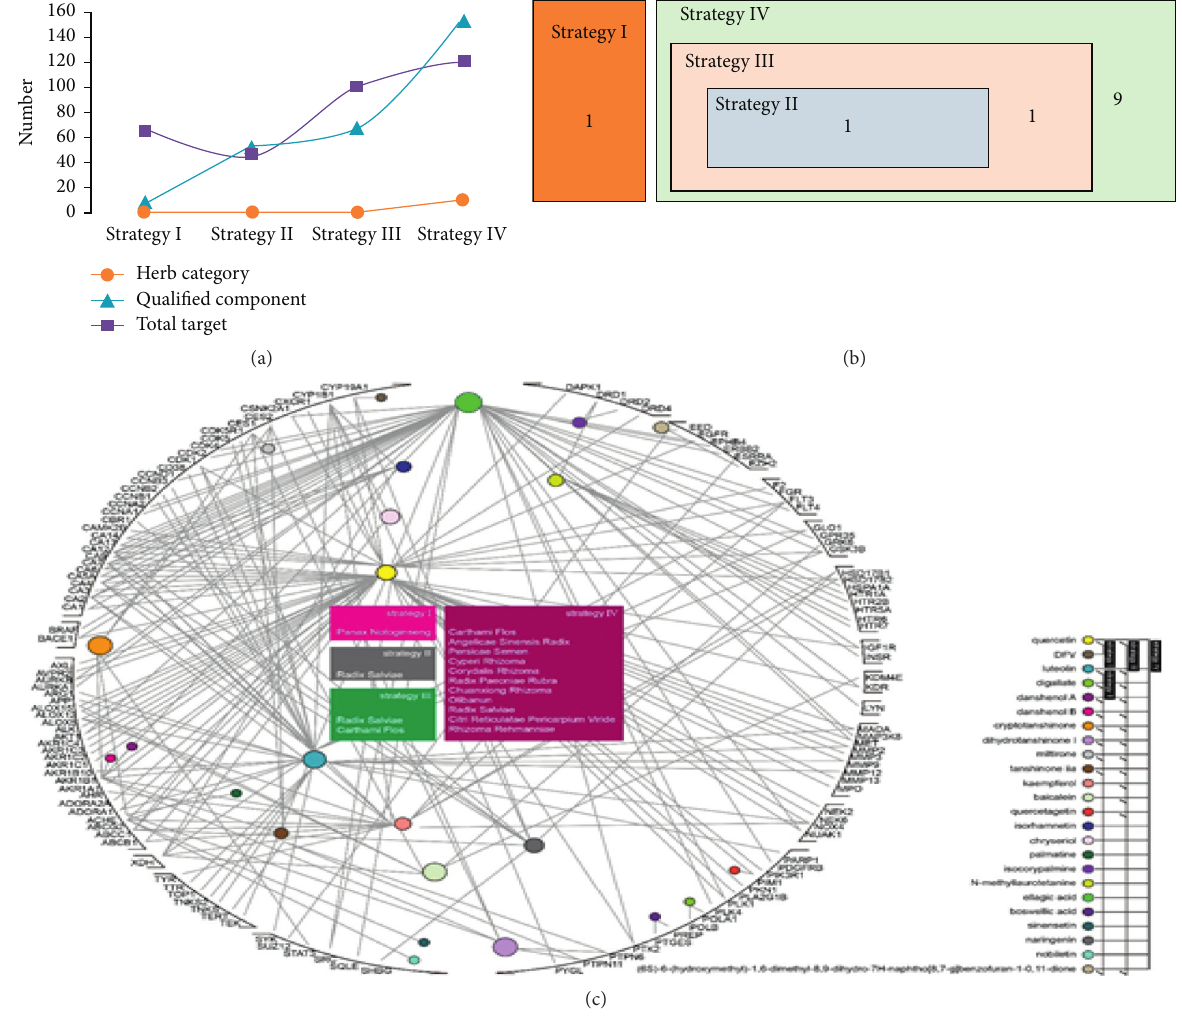
Figure 1: Four herbal strategies. (a) Number and category of herbs and chemical components and targets of each herbal strategy. (b) Number of common or unique herb in four herbal strategies. (c) Correspondence between component and target in herbal